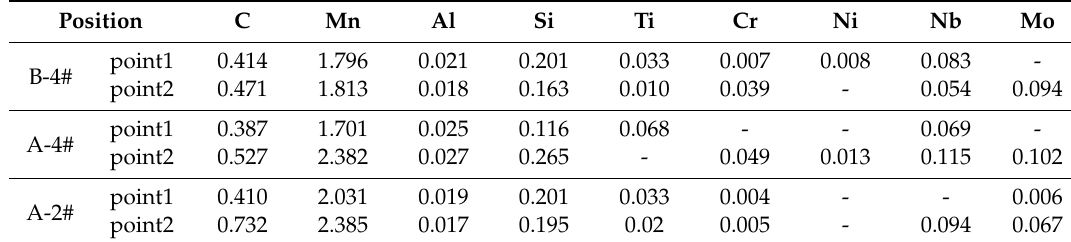
Table 2. Alloy component in the segregated region measured by electron probe micro-analyzer (wt.%). Position C Mn Al